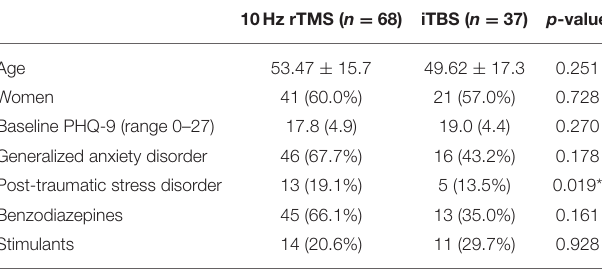
TABLE 1 | Baseline demographic and clinical characteristics of study participants